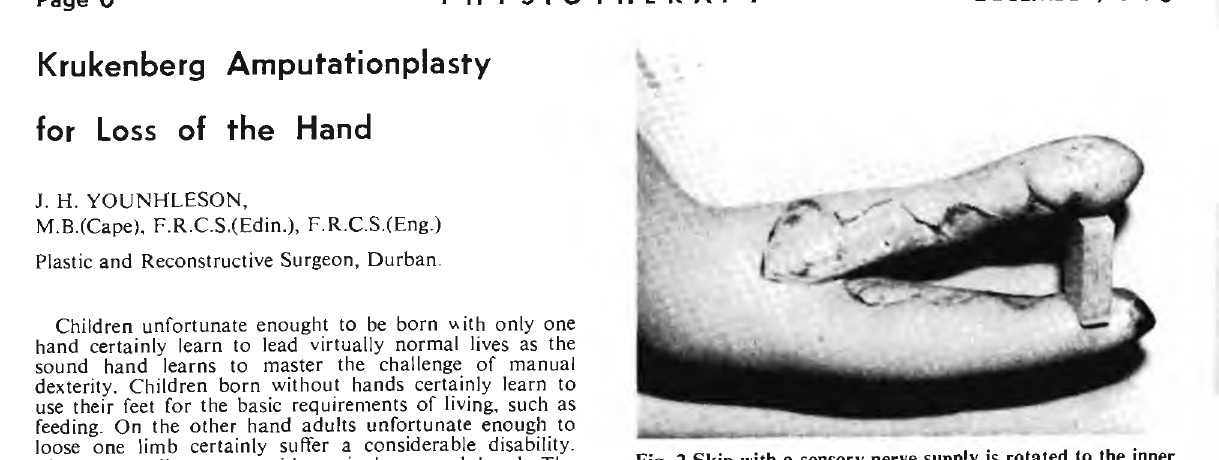
Fig. 2 Skin with a sensory nerve supply is rotated (o the inner sides of the pincer. The raw areas are covered by free skin grafts.